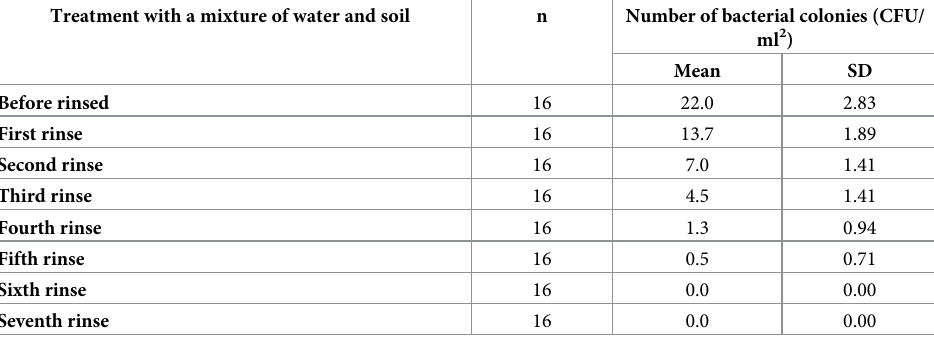
Table 2. Decrease in the number of bacteria due to the frequency of rinsing with water. Treatment with a mixture of water and